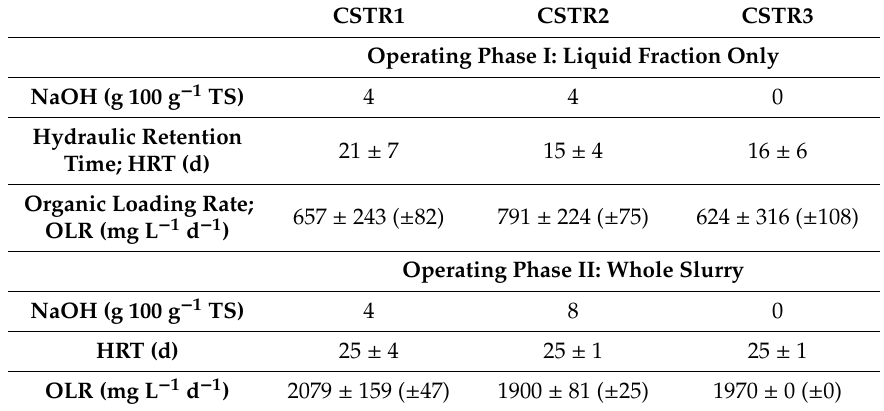
Table 5. Operating conditions of Continuous Stirred Tank Reactors (CSTRs) for both phases (values are given as the average ± standard deviations; numbers in parenthesis express the 95% confidence intervals on the mean values). CSTR1 CSTR2